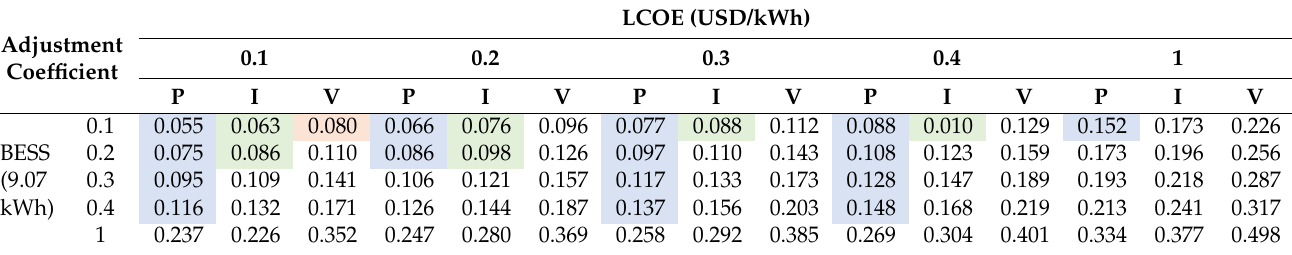
Table 17. LCOE sensitivity to investment adjustment in the three countries